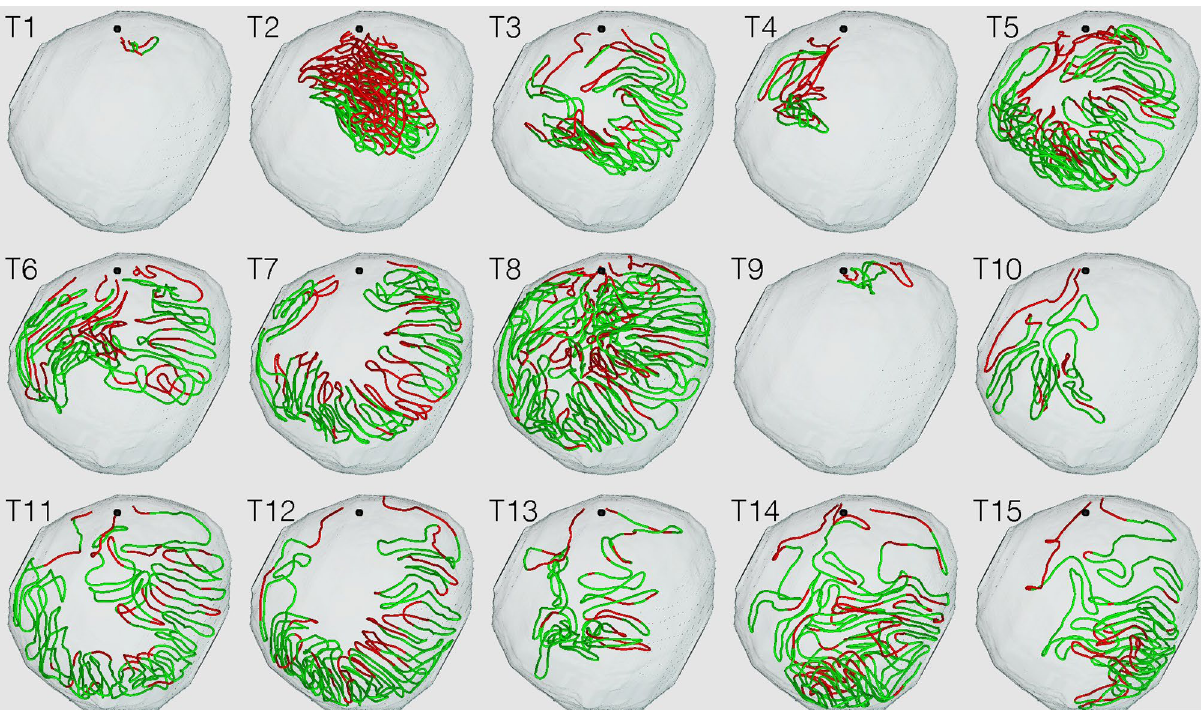
Figure 5. Distribution of normal and altered tubule segments at 24 months. The core lines of all reconstructed seminiferous tubules in testis #7 are shown in a horizontal view with the normal and altered segments shown in green and red, respectively, and the positions of the rete testis shown with black spheres. Tubules are numbered from T1 to T15 in the order of their connection with the rete testis from the top toward the bottom in the testis. Scale, 1